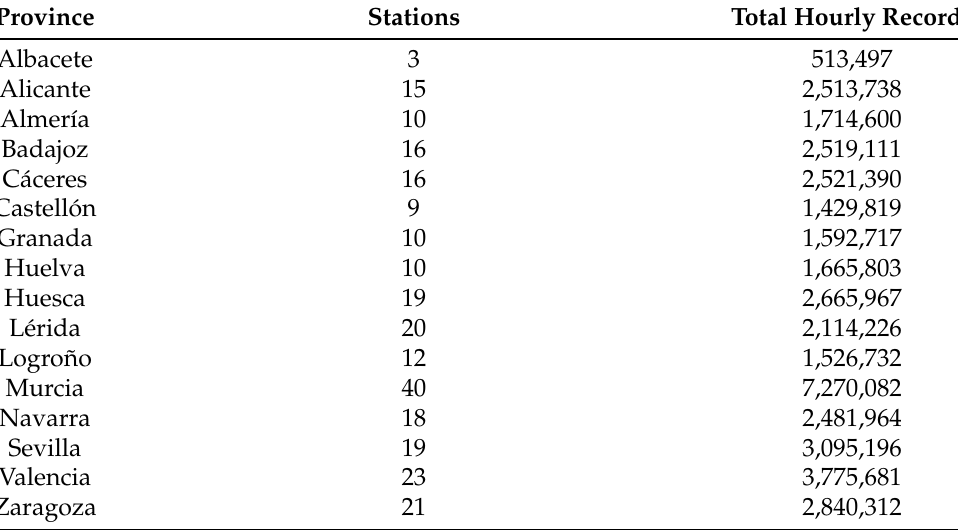
Table 1. Automatic stations by municipality and total number of collected records (data collected from January 2000 to March